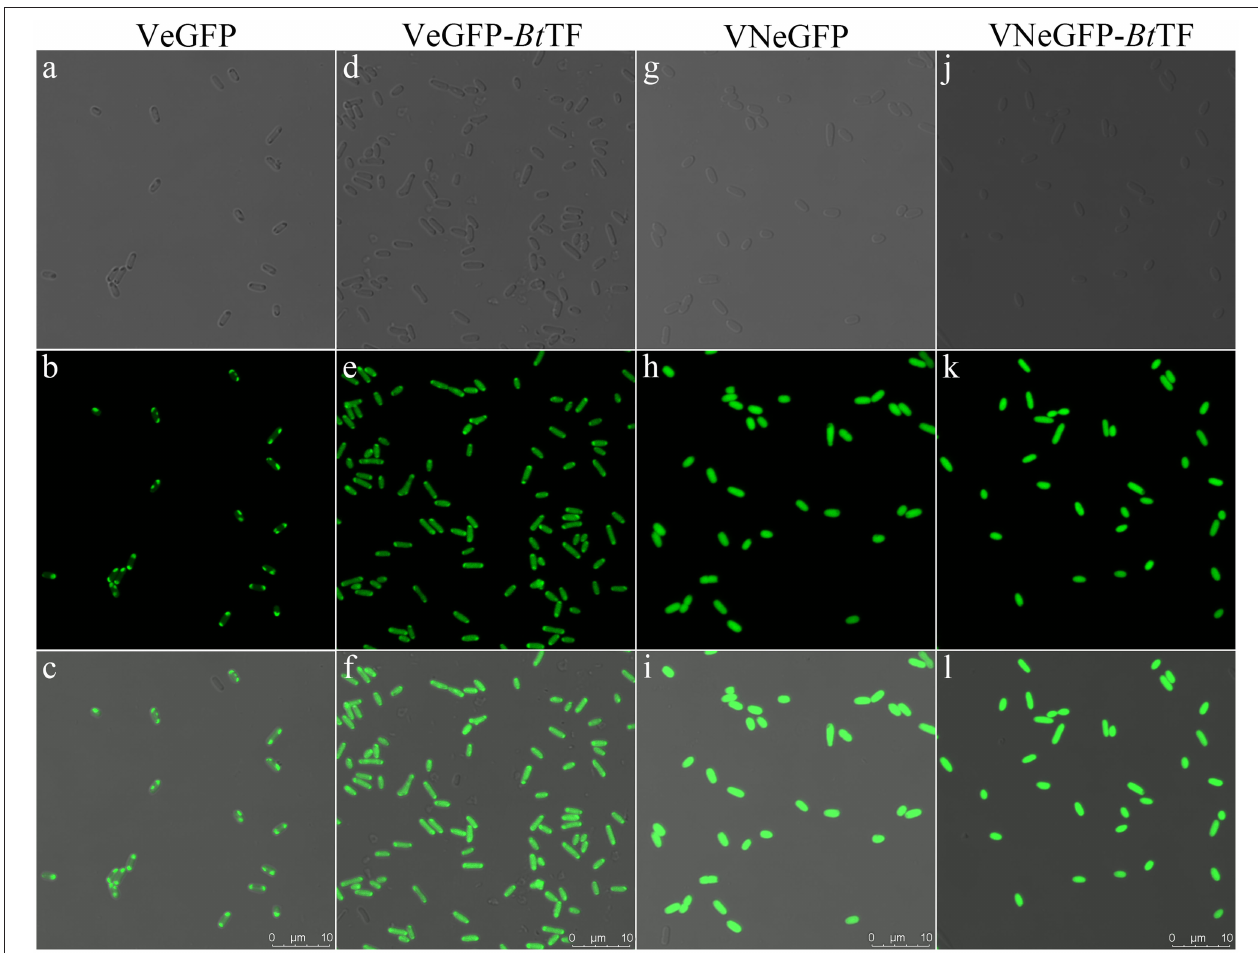
FIGURE 5 | The fluorescent signal distribution of VeGFP and VNeGFP in E. coli BL21-star (DE3) cells. The corresponding cells expressing VeGFP (a–c) or VNeGFP (g–h) individually, or with Bt TF d–f for VeGFP and j–l for VNeGFP) were observed using an inverted confocal microscope (Leica SP8). For each sample, the image in the third row was merged with the corresponding bright-field image in the first row and the fluorescent one in the second row. The scale bar represents 10 µ m.